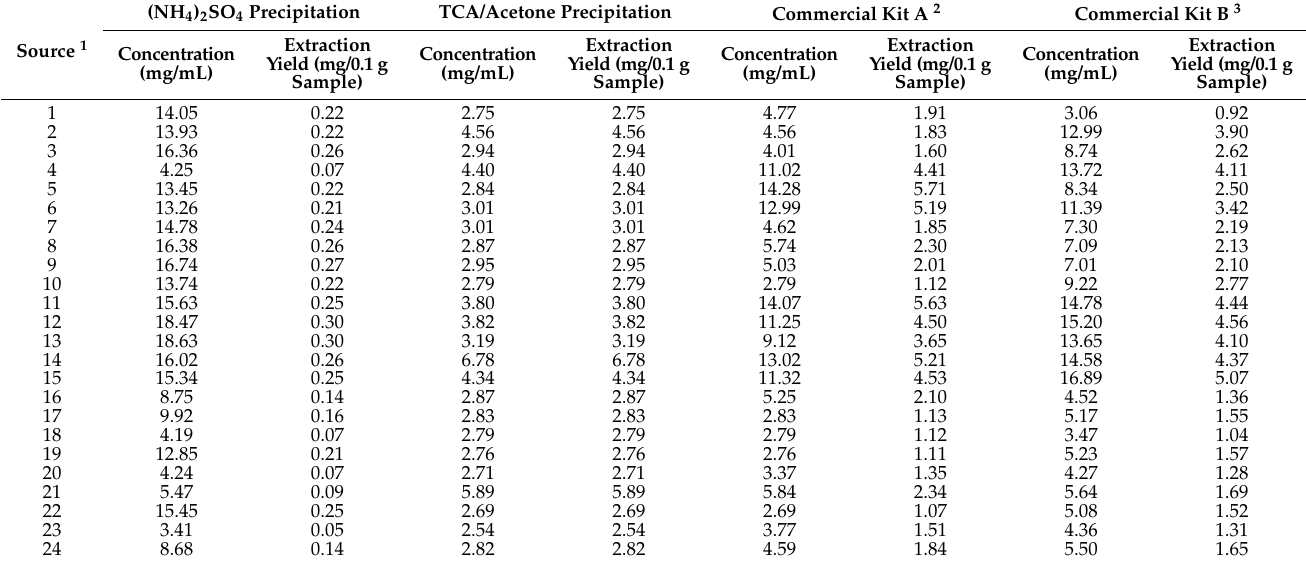
Table 1. Protein extraction yield of each protein extraction methodology from 24 domestic agricultural products.